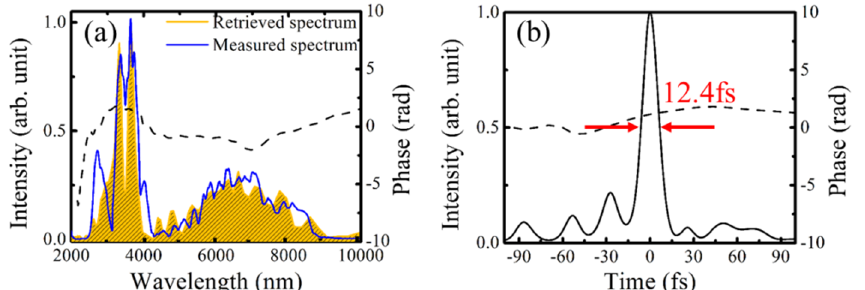
Figure 24. Temporal characterisation of the synthesised MIR pulse. The retrieved spectral ( a ) and temporal ( b ) intensity profiles of the synthesised pulse. The dotted curves are the retrieved phase. Pulse width (12.4 fs) at full width at half maximum is measured with a centre wavelength at 4.2 μ m. It corresponds to 0.88 optical cycle. Reprinted with permission from [35].